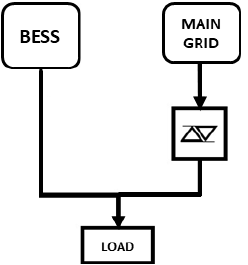
Figure 4. Static Transfer Switch (STS).